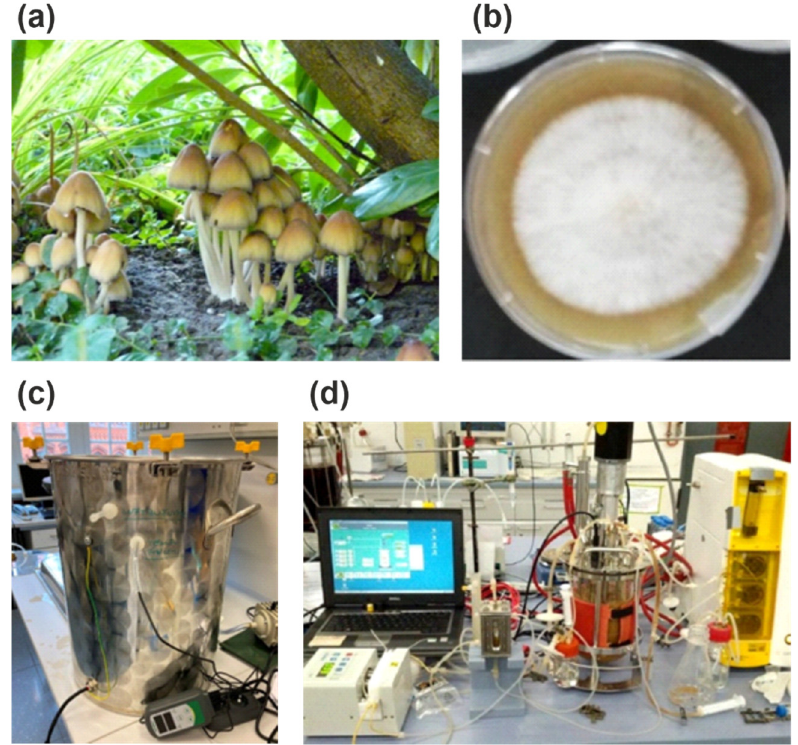
Figure 1. ( a ) The typical morphology of a xylophilic basidiomycete with stipe and pileus growing on the rotting roots of a willow tree (here: Coprinus micaceus ). ( b ) Emerse cultivation of Pleurotus sapidus on agar plates supplemented with 5% ( w / v ) lemon peel. ( c ) Simple temperature controlled and aerated stainless-steel tank for the solid-state cultivation of mycelium of a basidiomycete. ( d ) Submerged cultivation in a lab-scale fermenter requires more complex peripheral instrumentation, such as pH and oxygen probes, pumps and electronic data processing (© pictures by the authors).